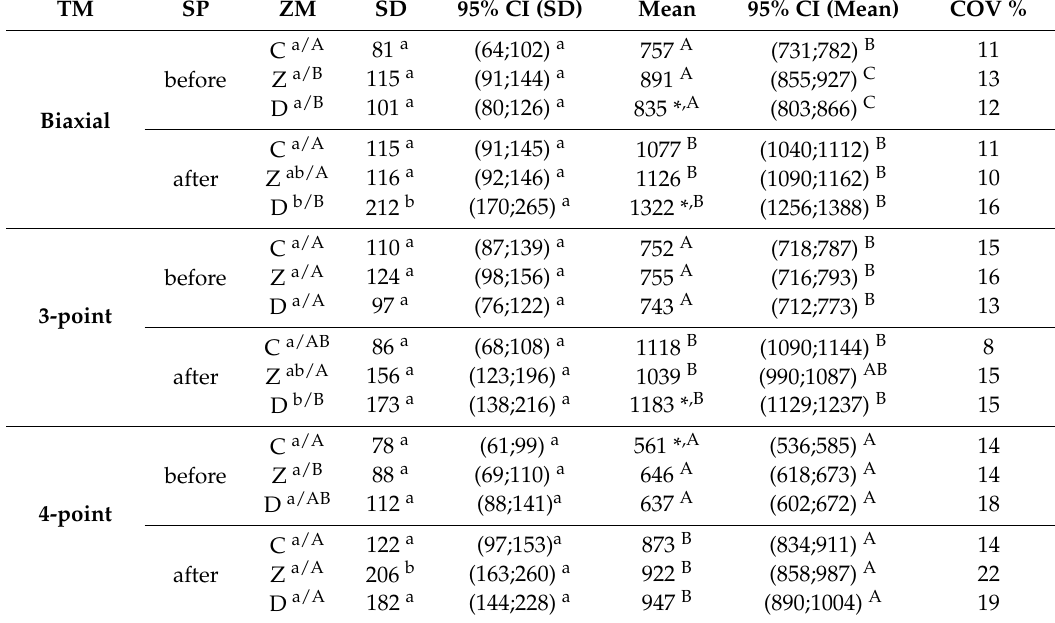
Table 5. Descriptive statistics for flexural strength values of all measured groups. TM: test method; SP: specimen preparation; ZM: zirconia material; SD: standard deviation; 95% CI: 95% confidence interval; Min: minimum; Max: maximum; COV: coefficient of variation (%). If not otherwise indicated